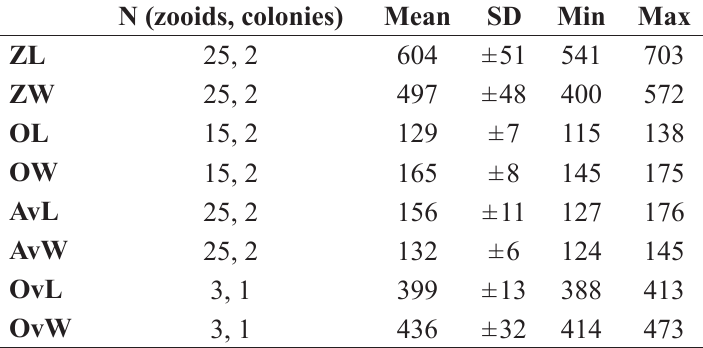
Table 3. Measurements in µm of Microporella hastigera (Busk, 1884), Recent, Challenger Expedition, St. 75; lectotype NHMUK 1887.12.9.547 and paralectotype NHMUK